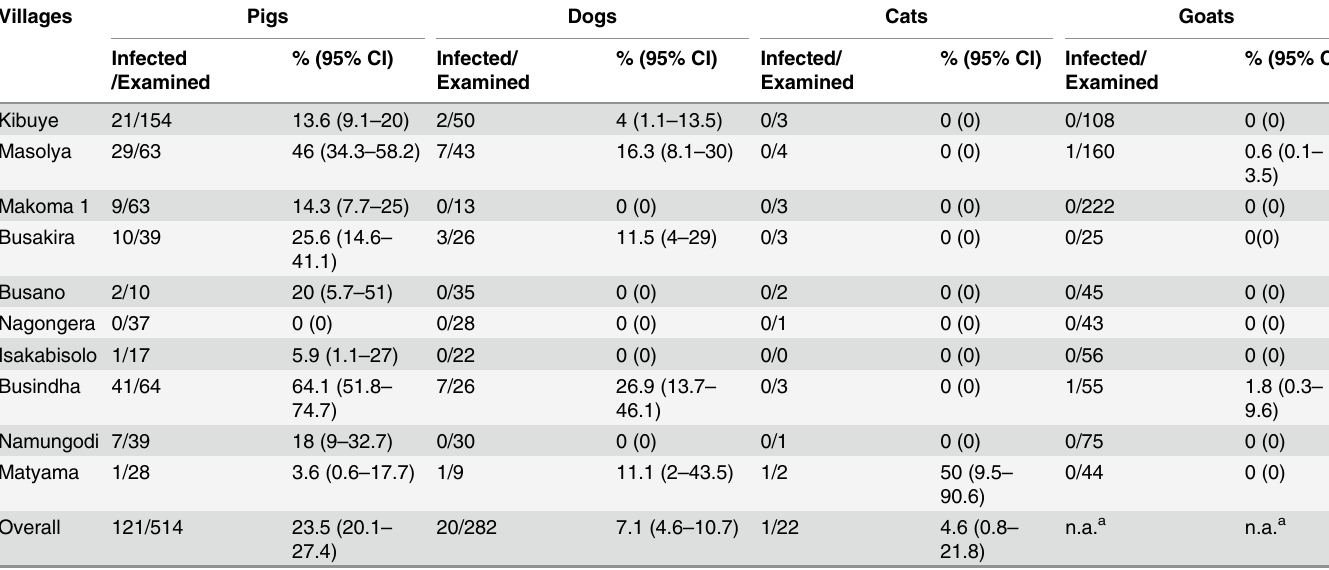
Table 2. Prevalence of tungiasis in the four animal species which were found to be infected with T . penetrans .